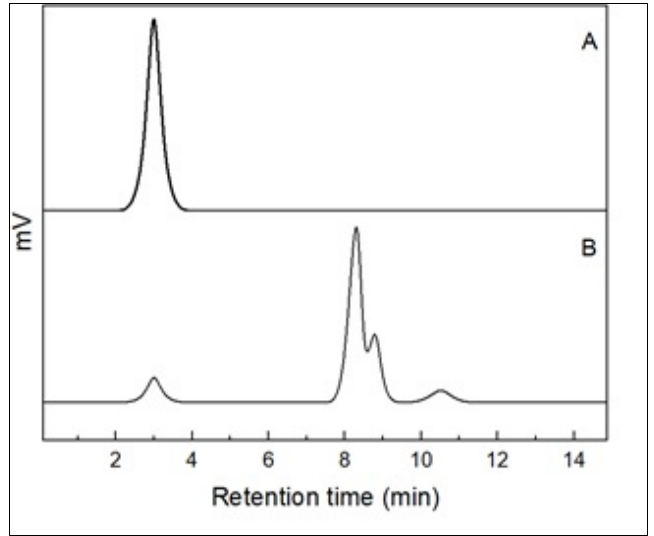
Figure 1. Chromatogram of HPLC analysis of citrus peel pectin ( A ) and hydrolyzed citrus peel pectin ( B ) with Pectinex Ultra AFP in a concentration of 1.25 μ L/g.